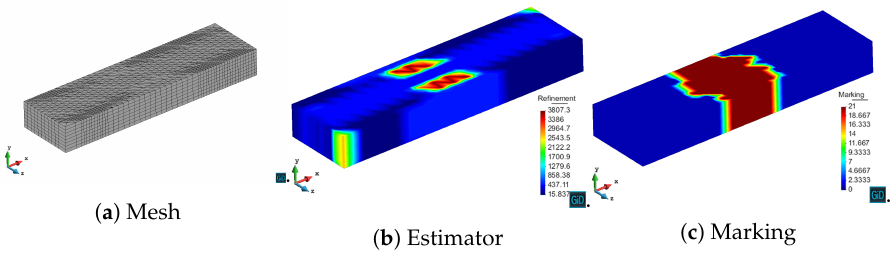
Figure 16. Third iteration for a structured mesh of a WR-90 waveguide.